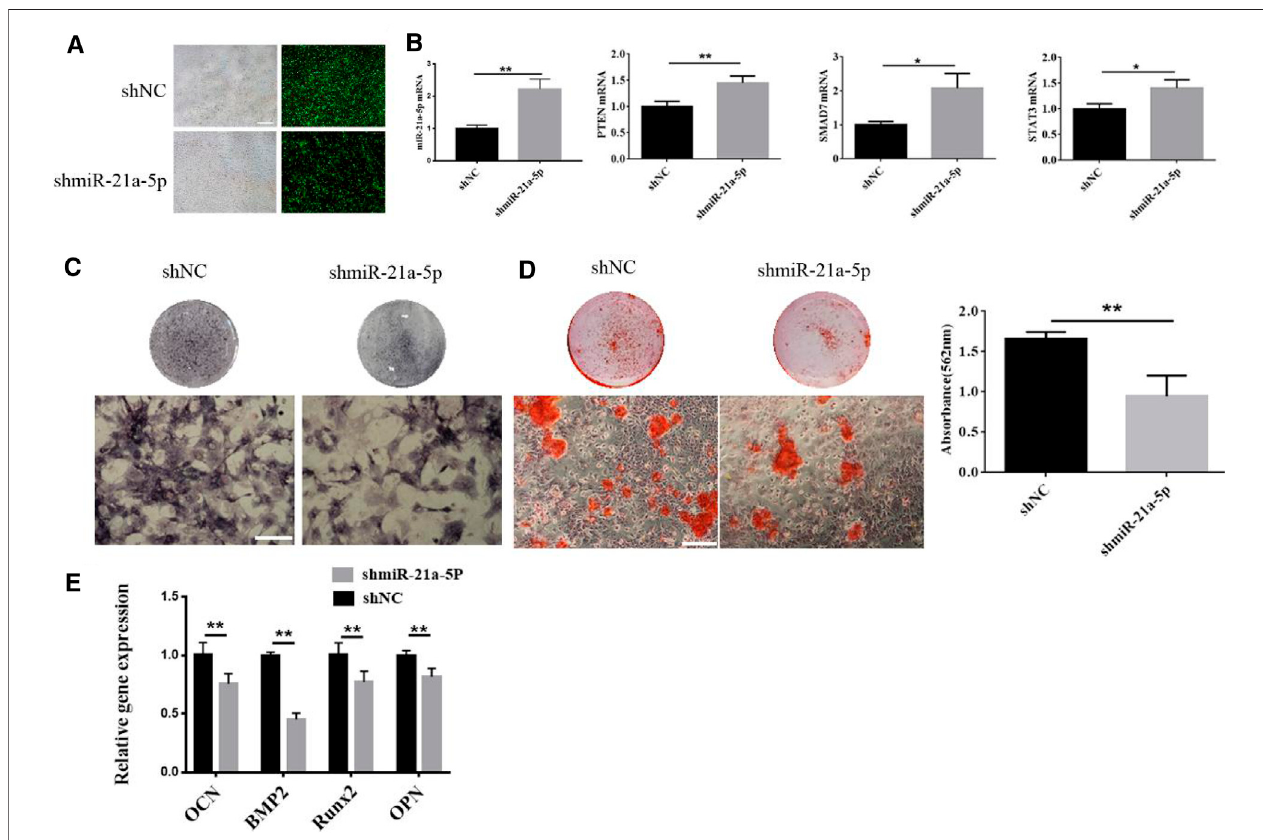
FIGURE 4 | Effect of knocking down miR-21a-5p in M1 macrophages on osteogenic differentiation of BMSCs. (A) sh-miR-21a-5p were knocked down using a lentiviral transfection technique. (B) qPT-PCR was used to verify the expression of miR-21a-5p, SMAD7, PTEN, and STAT3. ** p < 0.01. (C) ALP staining in BMSCs (Scale bars, 100 μ m). (D) Alizarin red S staining and quanti fi cation in BMSCs (Scale bars, 100 μ m). (E) The expression of osteogenic gene was detected by qRT-PCR (7 days).Data are presented as mean ± SD. *p < 0.05, **p < 0.01 represent signi fi cant differences between the indicated columns.